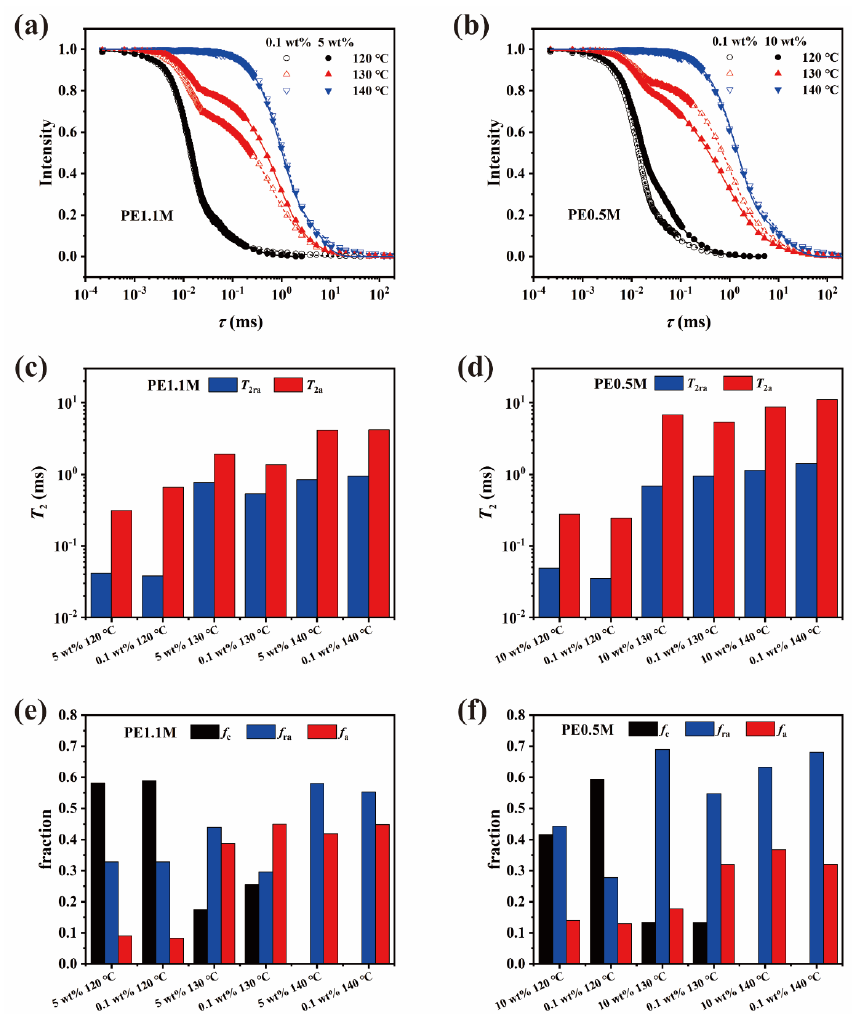
Figure 4. FID signals of ( a ) PE1.1M and ( b ) PE0.5M obtained by MSE and Hahn Echo at temperatures near T m . The solid and dashed lines represent fitting curves of FID for well-entangled and less-entangled samples, respectively. T 2 of rigid-amorphous intermediate phase ( T ra ) and flexible amorphous phase ( T a ), a fraction of crystalline phase ( f c ), rigid-amorphous intermediate phase ( f ra ) and amorphous flexible phase ( f a ) obtained by FID fitting with Equation (2) are located at ( c – f